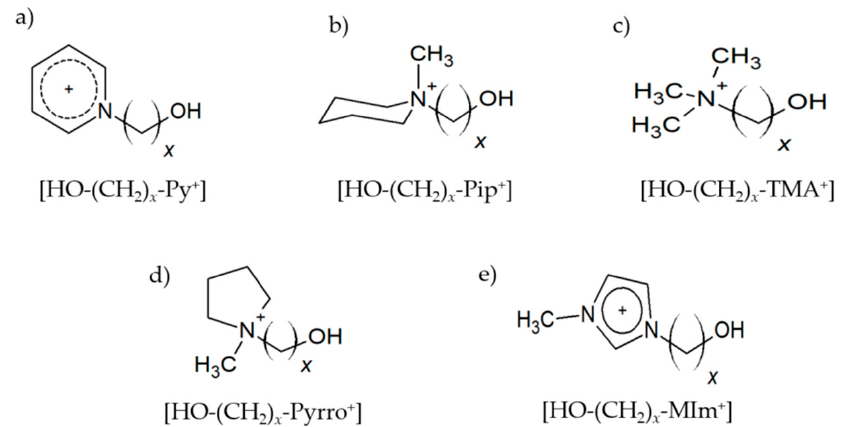
Figure 1. Hydroxy-functionalized cations ( a ) 1-( x -hydroxyalkyl)pyridinium [HO-(CH 2 ) x -Py + ], ( b ) 1-( x -hydroxyalkyl)methylpiperidinium [HO-(CH 2 ) x -Pip + ], ( c ) 1-( x -hydroxyalkyl)-1,1,1-trimethylammonium [HO-(CH 2 ) x -TMA + ], ( d ) 1-( x -hydroxyalkyl)methylpyrrolidinium [HO-(CH 2 ) x -Pyrro + ], and ( e ) 1-( x -hydroxyalkyl)-3-methylimidazolium [HO-(CH 2 ) x -MIm + ] with varying chain length x = 2–6 as constituents of cationic clusters.